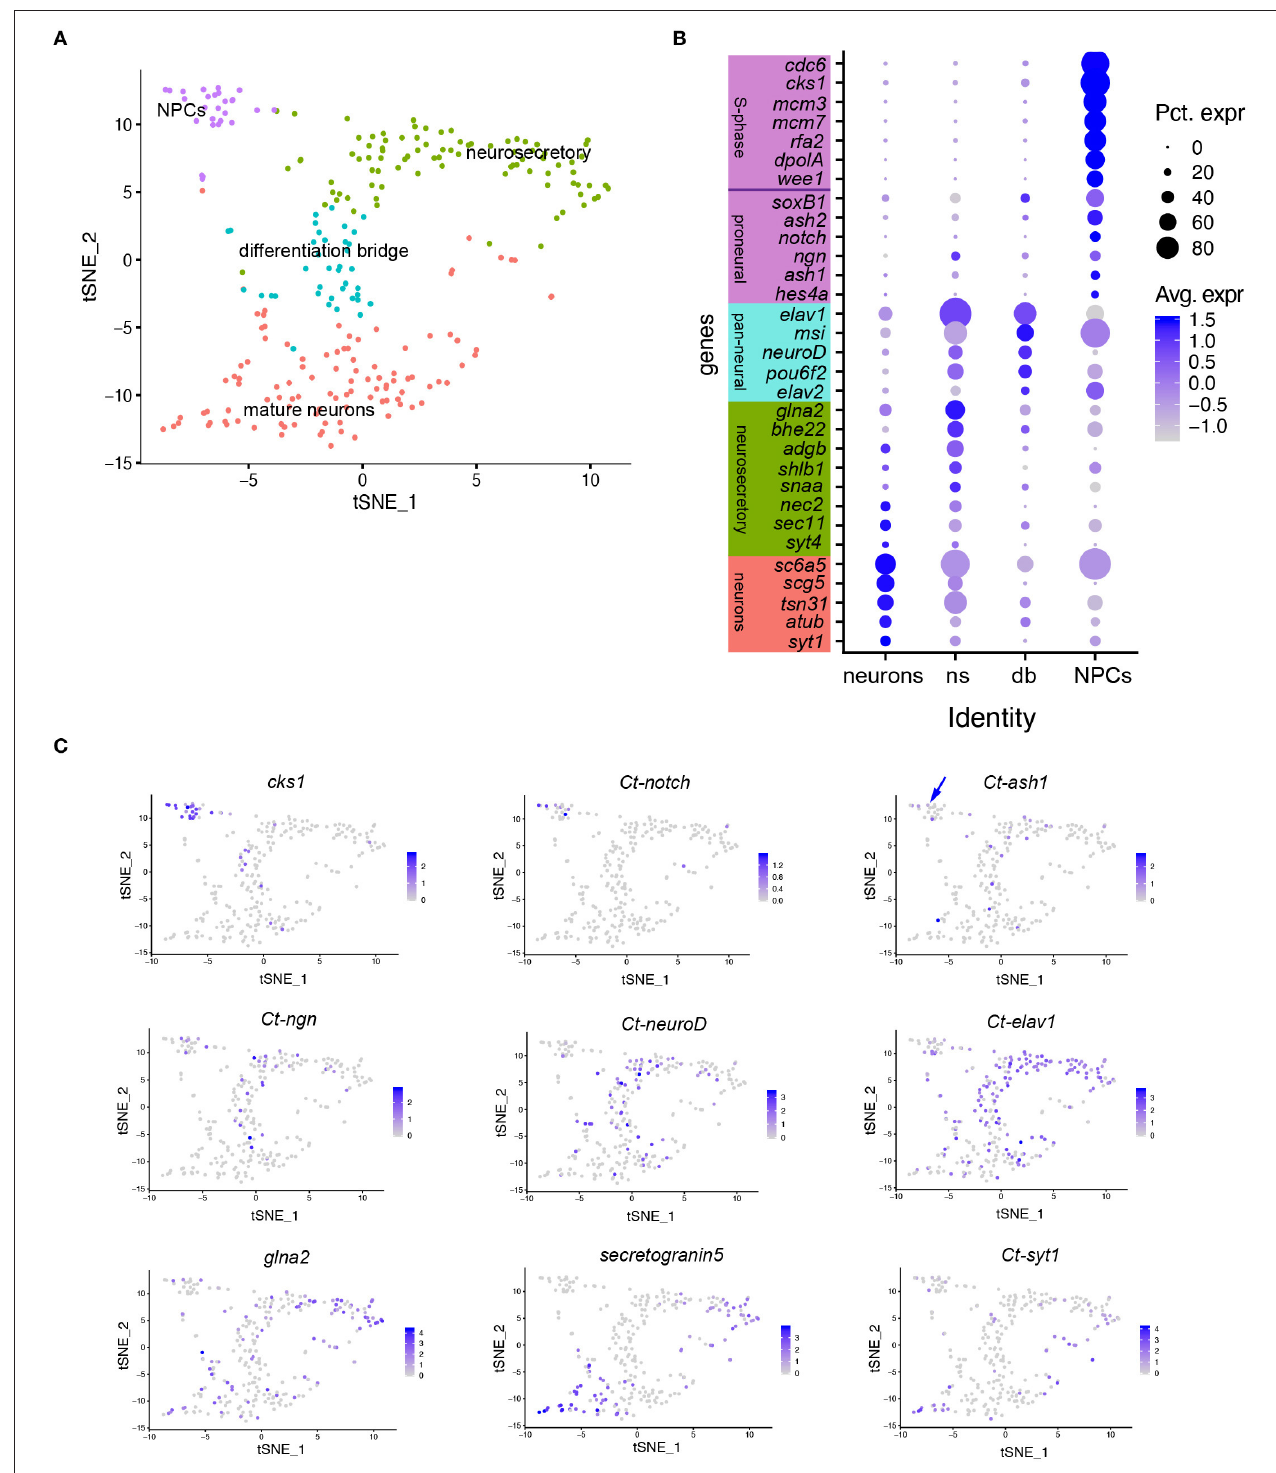
FIGURE 5 | Neural cell type diversity in stage 5 larvae. (A) t-SNE representation of single cells obtained from the neural + neurosecretory cell clusters generated from unsupervised clustering of the stage 5 dataset, labeled and colored based on cluster identity (B) Dotplot showing differentially expressed genes per neural cell type identified. Each row represents a single gene regulating individual aspects of neurogenesis whereas each column represents one of the four neural cell types. The expression is log normalized per gene. (C) t-SNE plots colored by expression of selected marker genes that were used for identifying each cell type. The color key indicates expression levels (purple: high; gray: low). Blue arrow highlights expression of Ct-ash1 in the NPC cluster. db, differentiation bridge; ns, neurosecretory.